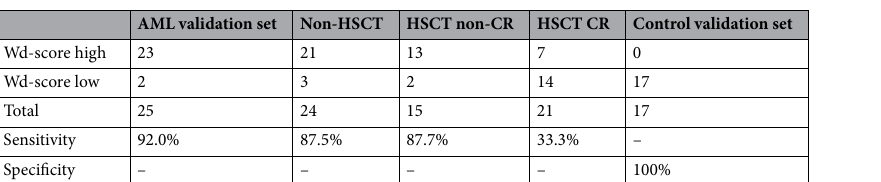
Figure 2. A 5hmC signature differentiates AML patients from controls. ( a ) Principal component analysis (PCA) in AML patient samples at registration time points and controls using normalized read counts from the 5hmC signature of 70 genes. ( b ) Unsupervised hierarchical clustering of the 5hmC signature of 70 genes in AML patient samples at registration time points and controls. ( c ) Boxplot of weighted-diagnostic scores (wd-scores) in controls and AML samples in both training (n = 62) and validation sets (n = 42). Black dashed line represents a cutoff score of 0.263 developed from the training set. P < 0.001, comparison of any of the AML groups to the control group in both training and validation sets. Center line represents median, bounds of box represent 25th and 75th percentiles, and whiskers are Tukey whiskers. ( d ) Boxplot of wd-scores in controls and other AML samples that were not included in the training, validation, and test sets. Non-HSCT, did not receive hematopoietic stem cell transplantation (n = 26); HSCT Non-CR, received hematopoietic stem cell transplantation and not in complete remission (n = 13); HSCT CR, received hematopoietic stem cell transplantation and in complete remission (n = 21). Center line represents median, bounds of box represent 25th and 75th percentiles, and whiskers are Tukey whiskers. ( e ) Receiver Operating Characteristics (ROC) analysis of wd-score calculated from the 5hmC signature of 70 genes in validation and test sets. AUC area under curve. CI 95% confidence interval. ( f ) Boxplot of wd-scores in additional AML samples and controls in the test set. Controls, n = 39. Non-CR did not achieve complete remission, n = 14. CR complete remission, n = 22. Center line represents median, bounds of box represent 25th and 75th percentiles, and whiskers are Tukey whiskers.